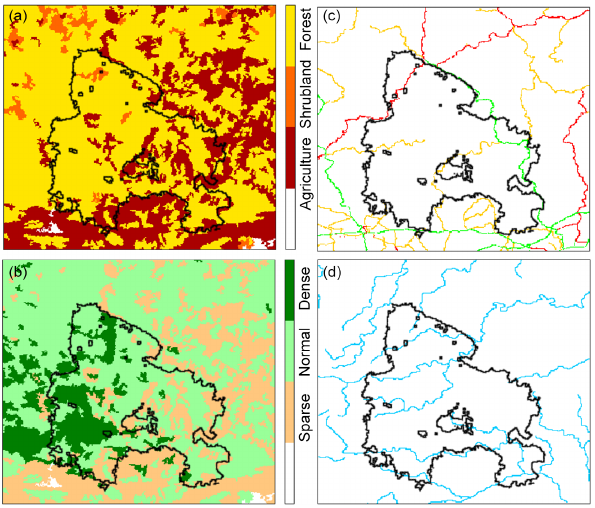
Figure 2. (a, b) Vegetation type (a) and density classes (b) inside the study area as indicated by the discrete color bars. White corre- sponds to areas without vegetation. (c, d) The roads (c) and water- lines (d) identified inside the simulation area. Primary, secondary and tertiary roads are represented, respectively, in red, orange and green. Waterlines are all colored in